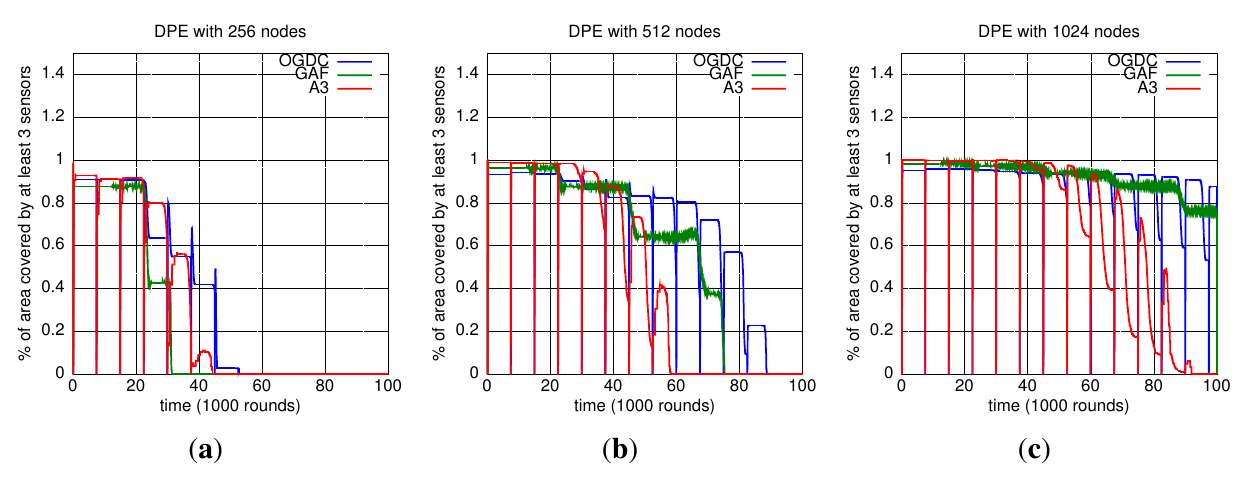
Figure 9. Localization, Density Control and 3-Coverage. ( a ) DPE; n = 256 ; ( b ) DPE; n = 512 ; ( c ) DPE; n = 1024